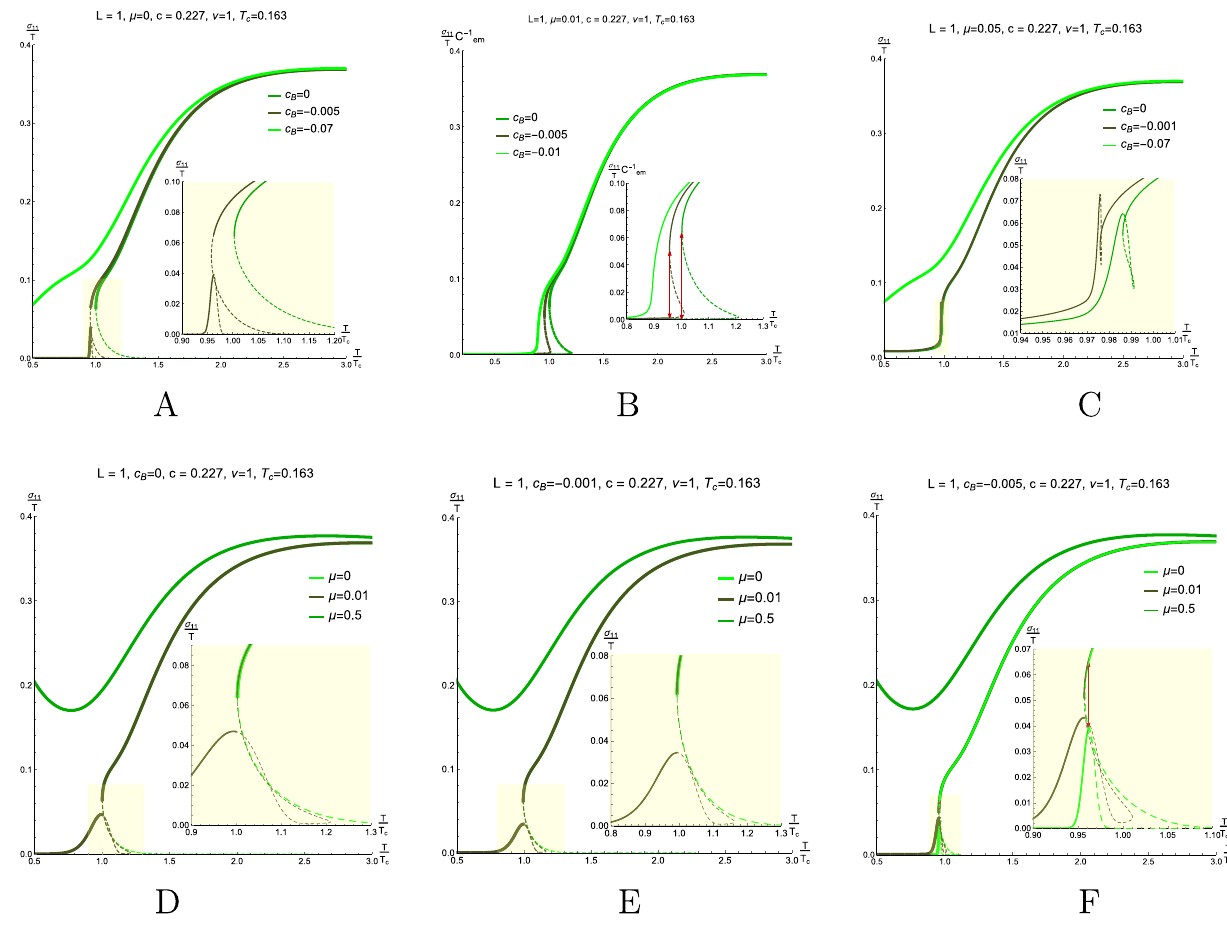
Fig. 7 Thedependenceof σ 11 / T onthenormalizedtemperature T / T c for different values of magnetic field’s parameter c B and μ = 0 ( A ), μ = 0 . 01 ( B ) and μ = 0 . 05 ( C ), and for different values of chemical potential μ and c B = 0 ( D ), c B = − 0 . 001 ( E ) and c B = − 0 . 005 ( F ).